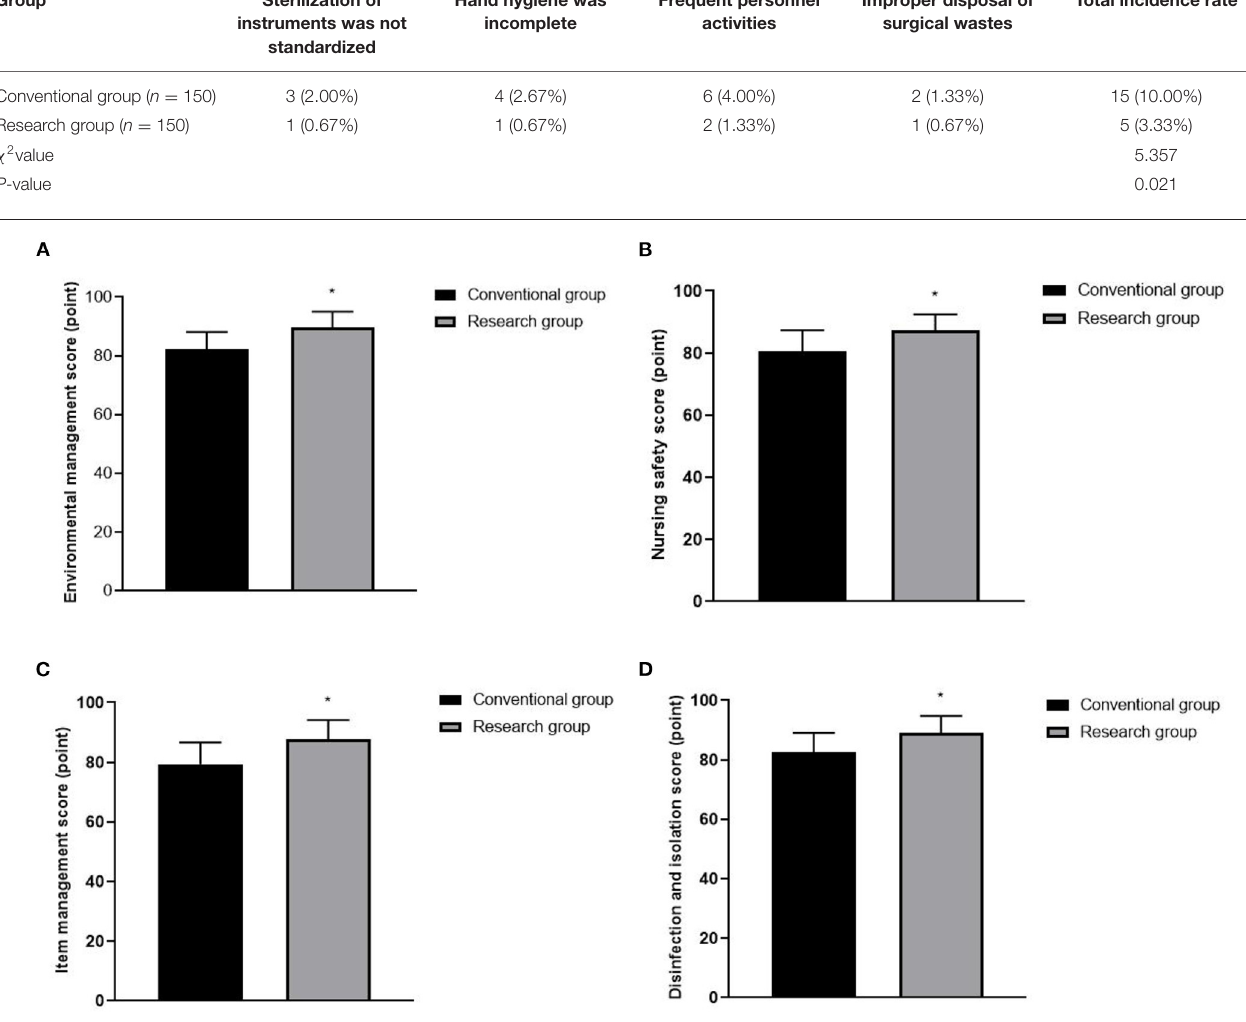
FIGURE 1 | Nursing quality in operating room for the two groups. (A) Environmental management score. (B) Nursing safety score. (C) Item management score. (D) Disinfection and isolation score. Compared with the conventional group, * P <